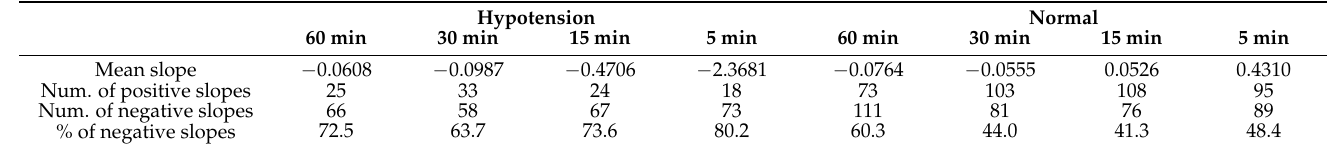
Table 3. HR slope values of 1 h, 45 min, 30 min, and 5 min data for IDH and normal (Non ‐ IDH) patients before onset of IDH.